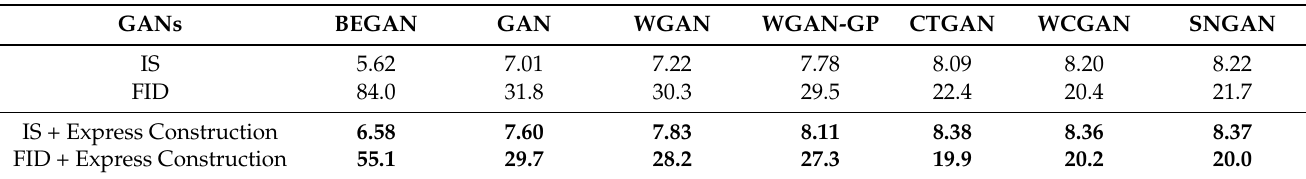
Figure 4. CIFAR-10 images generated without supervision by a small and large scale network, respectively. Table 2. The Inception Score (IS) and the Fréchet Inception Distance (FID) for Express Construction using different cost functions. We can say that it can outperform or match the benchmark. The best score is marked in bold.